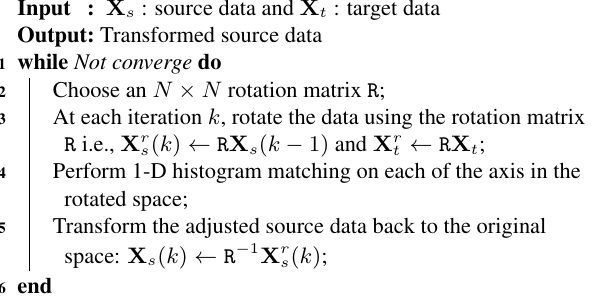
Algorithm 1: Multi-dimensional probability distribution